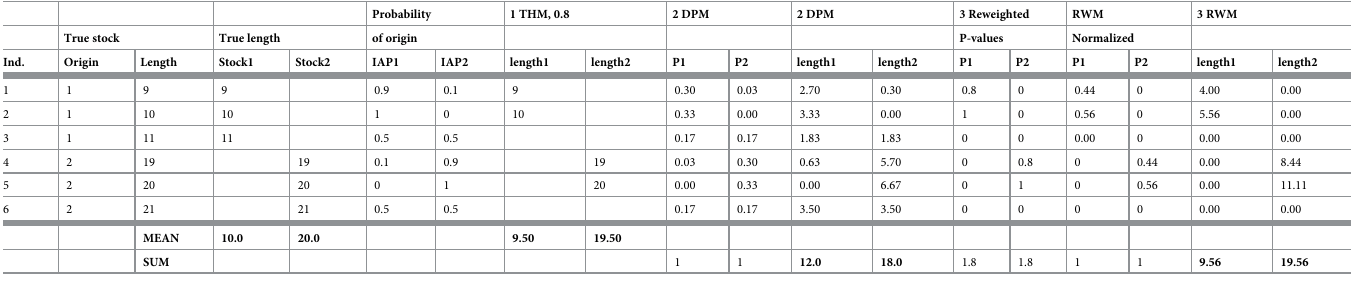
The compared methods were (1) the threshold method (THM) with a cut-off probability point of 0.8, (2) the direct use of individual assignment probabilities (DPM) for defining lengths, and (3) reweighting of the original individual assignment probabilities (RWM). For the DPM and RWM methods, the mean of the length distribution in each stock is estimated as a sum of lengths of individuals weighted by